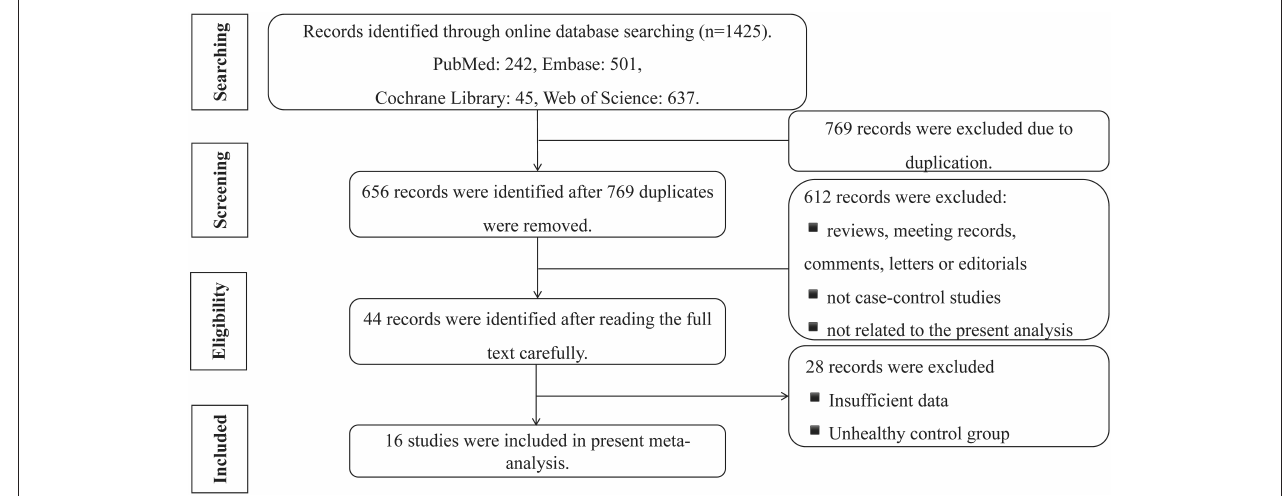
FIGURE 2 | Flow diagram of literature search and exclusion process.